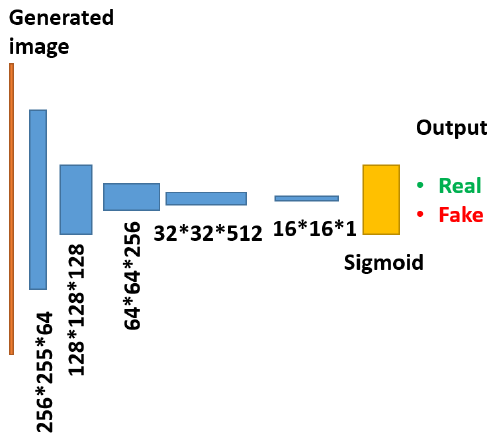
Figure 5. The architecture of the